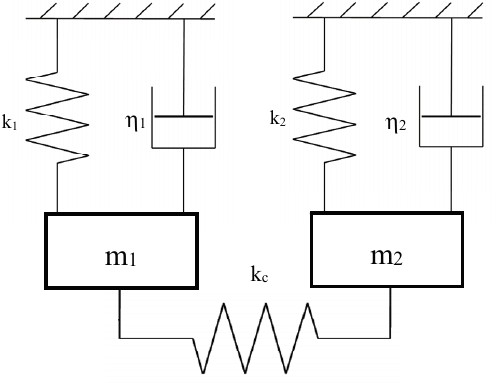
Figure 2. Schematic of the model of the coupled